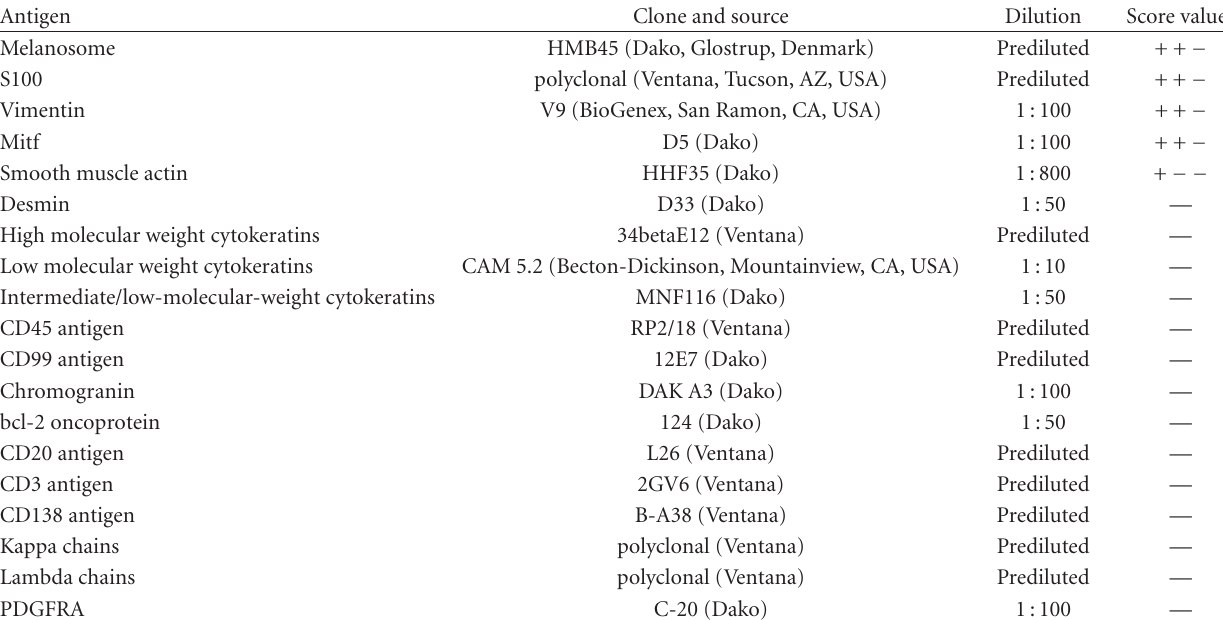
Table 1: Immunohistochemical profile of the tumor.